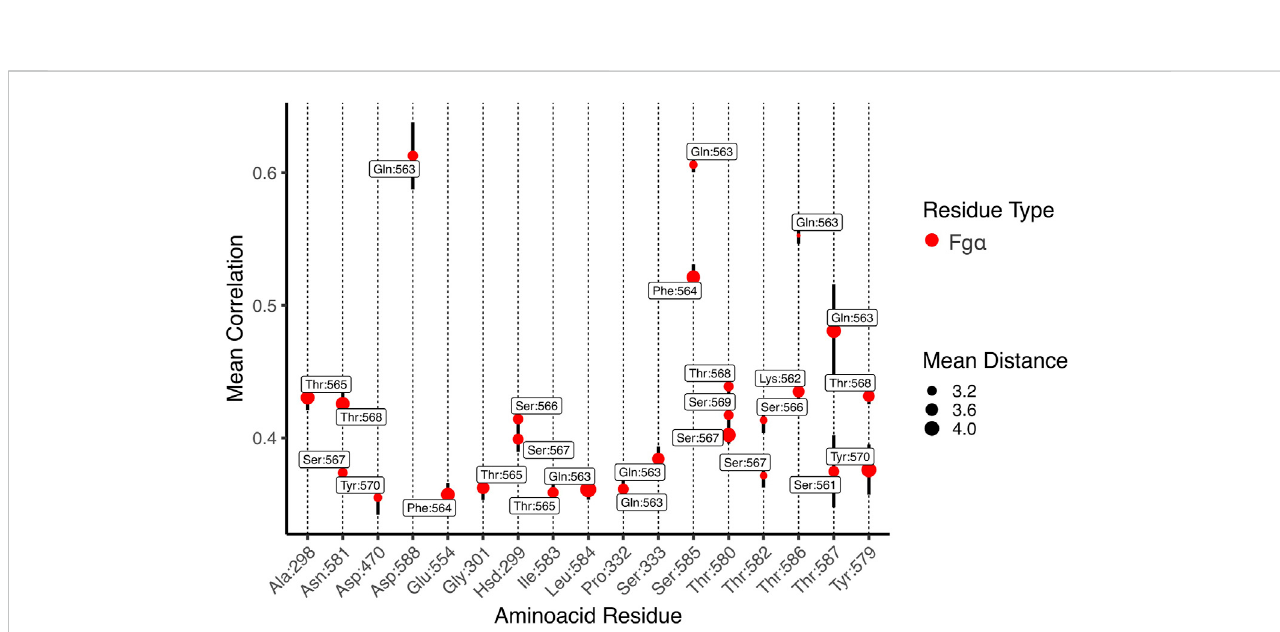
FIGURE 5 Mean generalized coef fi cients for contacts along Bbp:Fg α interface. The x -axis is labeled by Bbp amino acid residues and the y -axis indicates the averagedgeneralizedcorrelationvalues(verticalbarsindicatethestandarderrorofthemean),labeledbyFg α aminoacidresidues.Thecirclesizesindicatesthe average Cartesian distance. Only amino acid residues with a mean correlation higher than 0.35 are